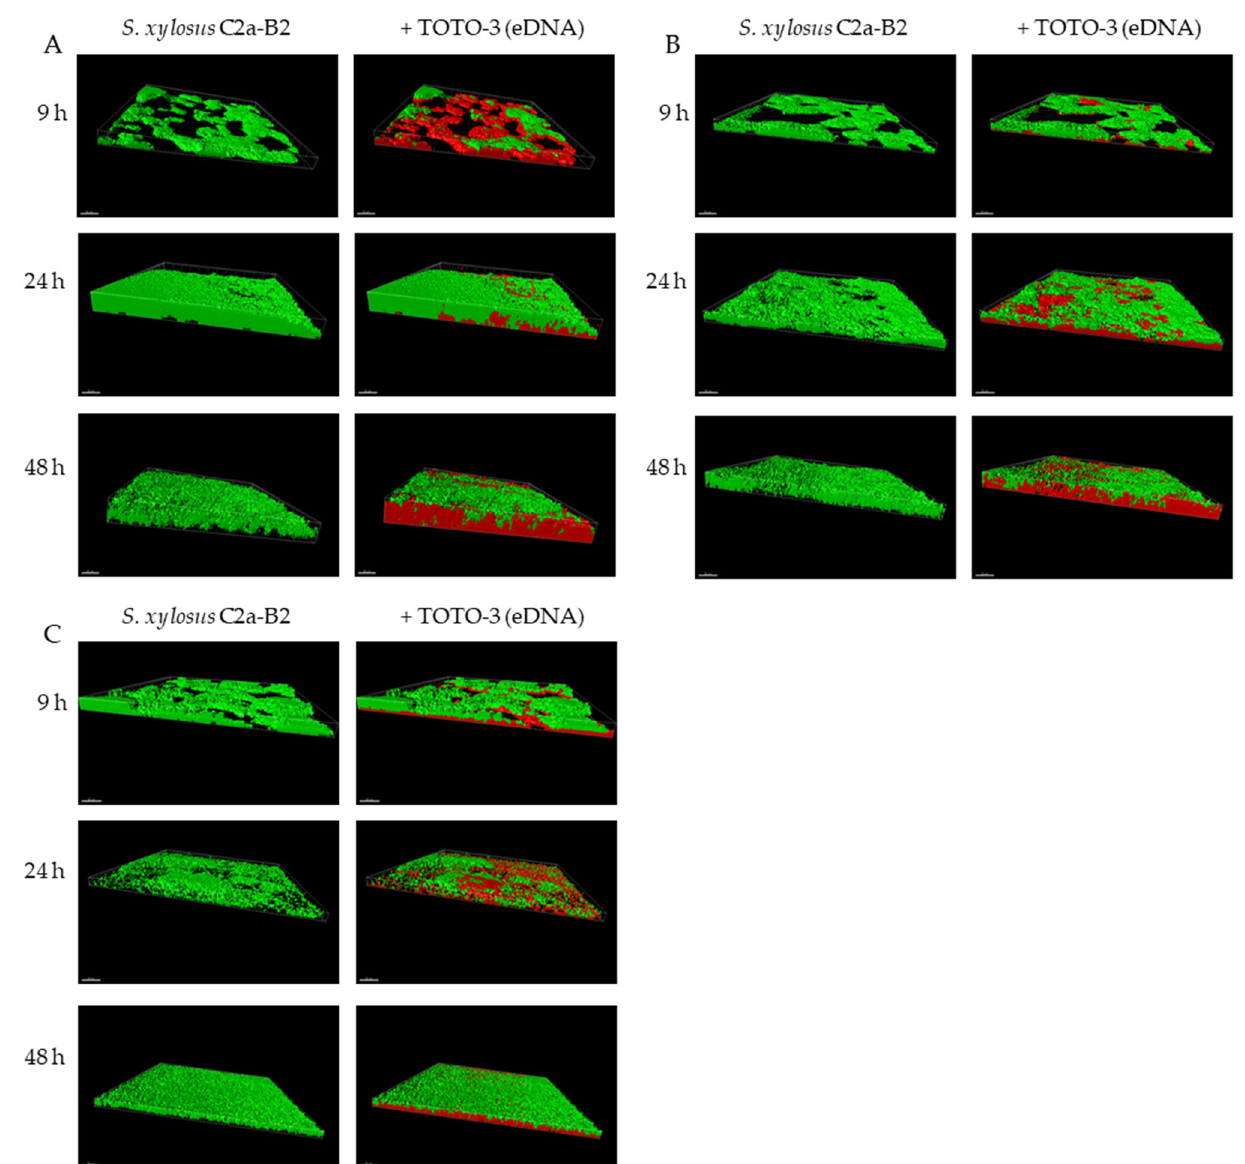
Figure 1. 3D projection of biofilms of S. xylosus C2a-B2 and DNA stained by TOTO-3 ( A ), after DNase treatment at the end of each incubation time ( B ), after incubation in the presence of DNase from the start ( C ), at three sampling times using Imaris software; Scale bar—30 µm .